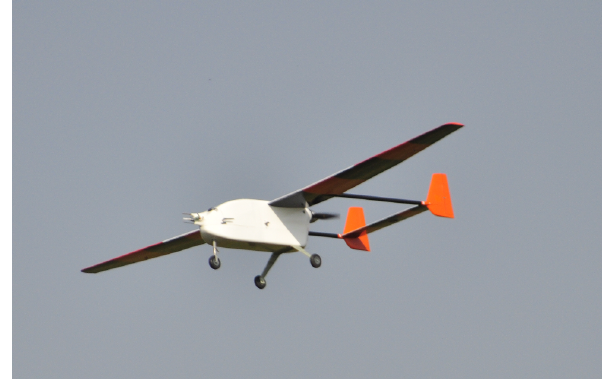
Figure 1. ALADINA during a measurement